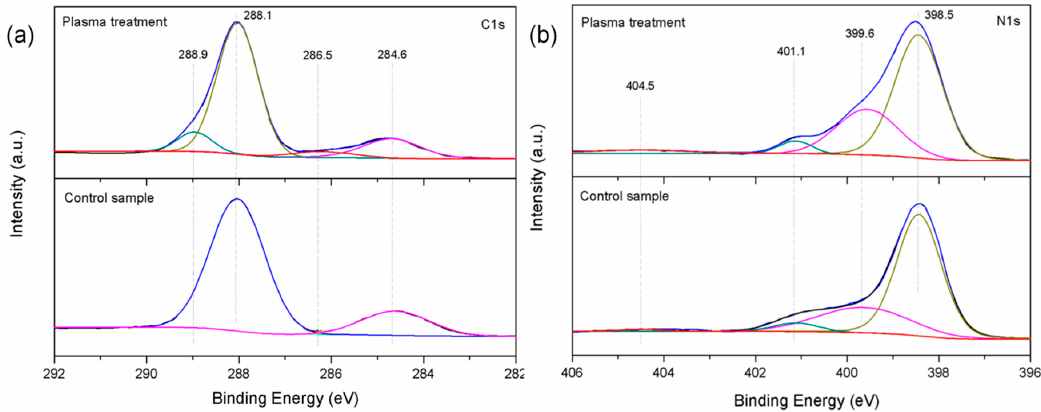
Figure 3. X-ray photoelectron (XPS) spectra of ( a ) C 1s, and ( b ) N 1s. (Plasma treatment time: 300 s; power: 60 W).